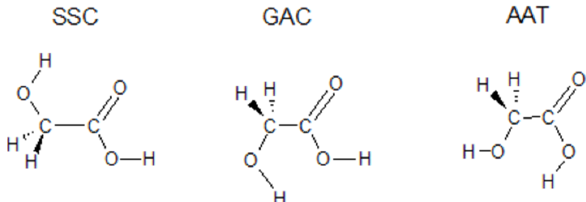
Figure 1. Structures of the three most stable conformers of glycolic acid monomer.